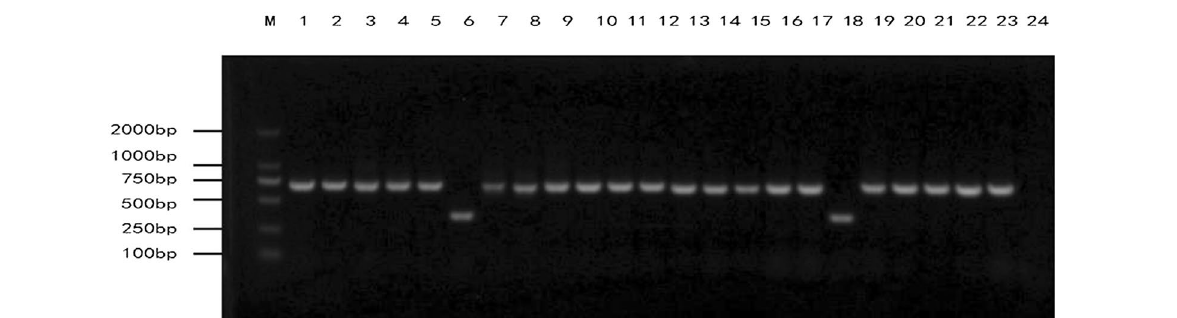
Fig. 4 Identification of phage display antibody library. The electro-transformed TG1 bacterial solution from 10 1 to 10 10 with fresh 2 was grown at 37 °C. The next day, the calculated volume of the phage antibody library was 1.8 from the 2 YT/AG plate for colony PCR identification. After 1% agarose gel electrophoresis, 22 clones with amplicons of 600 bp fragments were × obtained, and we calculated that the recombination rate of the antibody library was